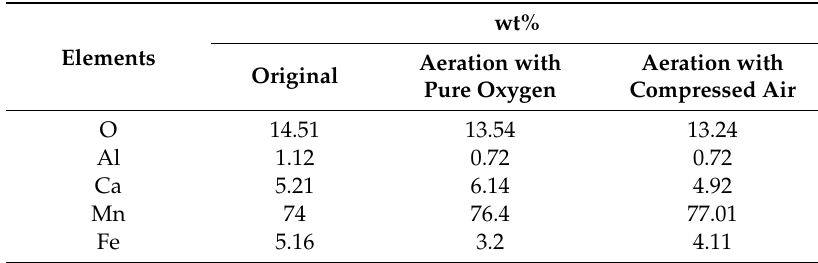
Figure 7. Scanning Electron Microscopy (SEM) images of the filter materials: ( a ) original, ( b ) aeration with pure oxygen, and ( c ) aeration with compressed air. Table 2. The major elements composition of MeO x